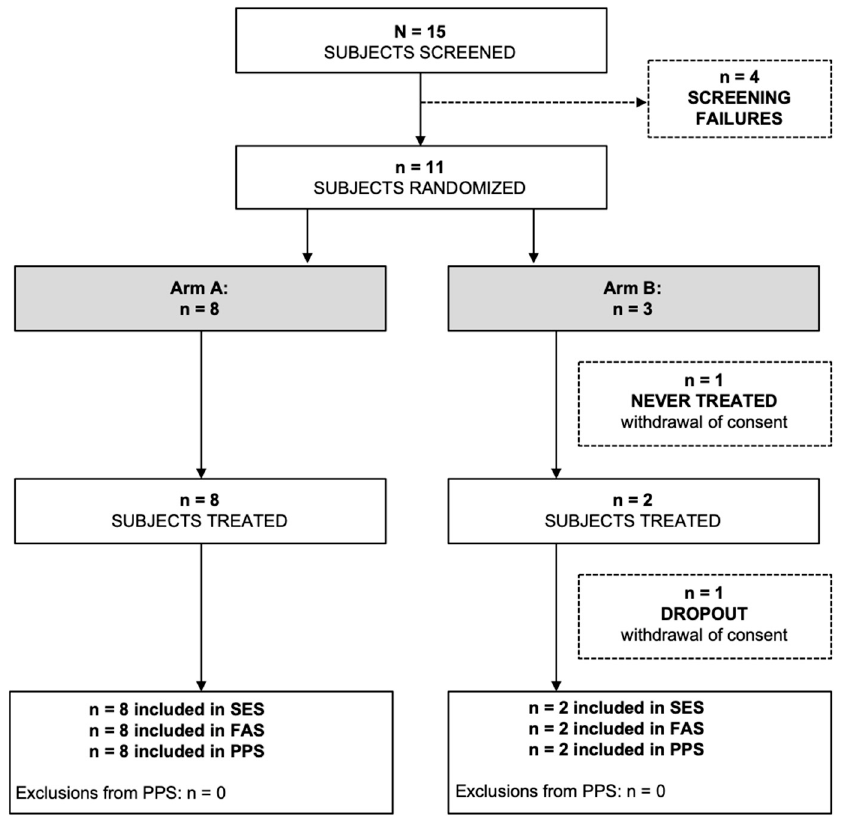
Figure 2. Consort diagram. Arm A, pazopanib; Arm B, physician-preferred chemotherapy; SES, safety evaluation set; FAS, full analysis set; PPS, per protocol set.